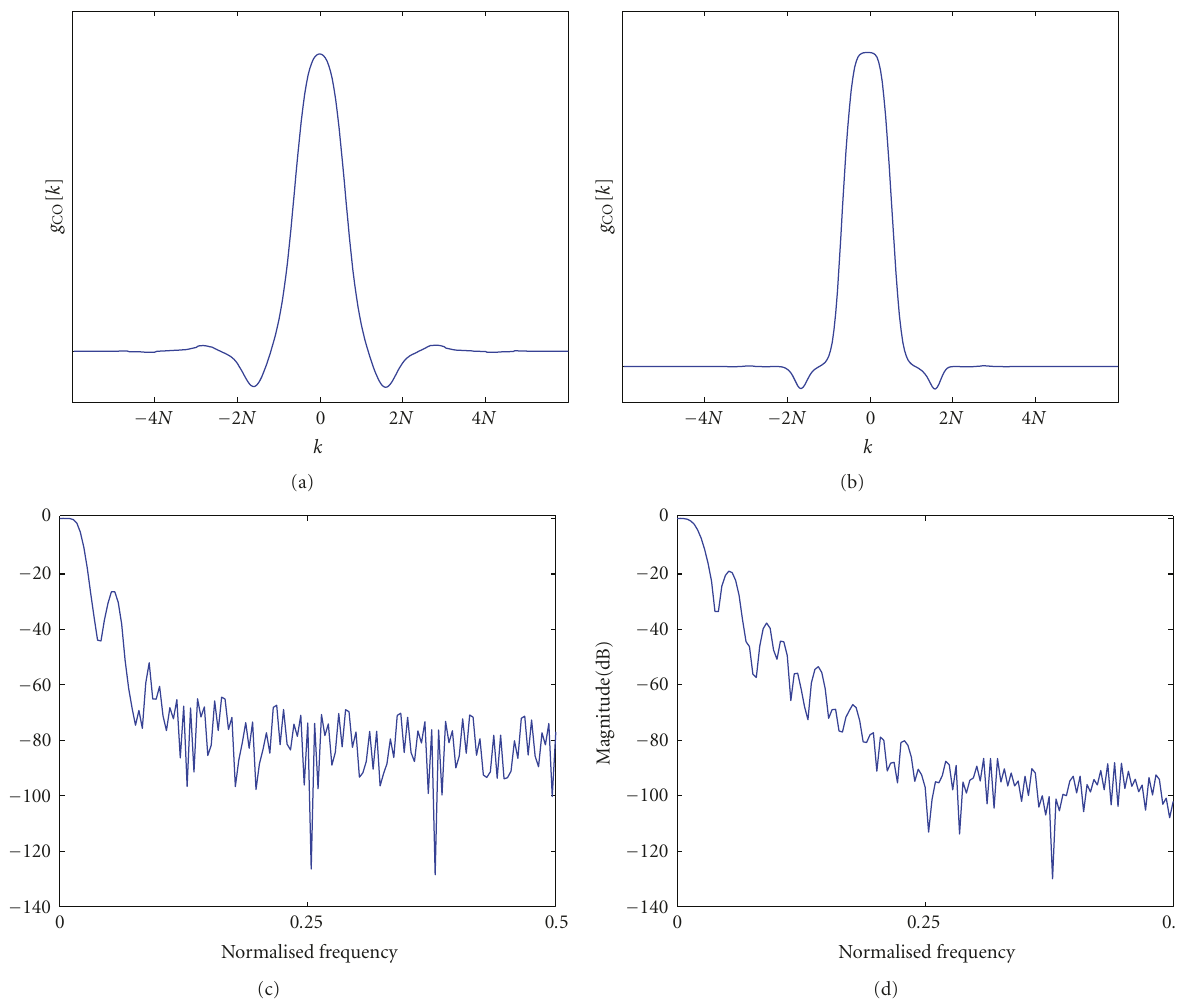
Figure 3: Examples of optimized window functions in time domain ((a) and (b)) and in frequency domain ((c) and (d)) for di ff erent channel statistics: τ RMS = 3, ν RMS = 0 . 001 (in (a) and (c)), τ RMS = 3, ν RMS = 0 . 01 (in (b) and (d)).